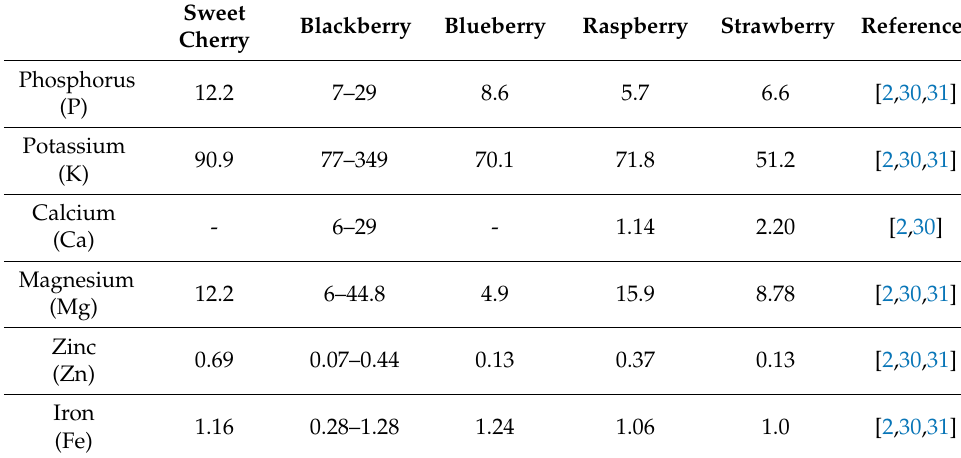
Table 2. Mineral content (mg/100 g FW) of some red fruits.